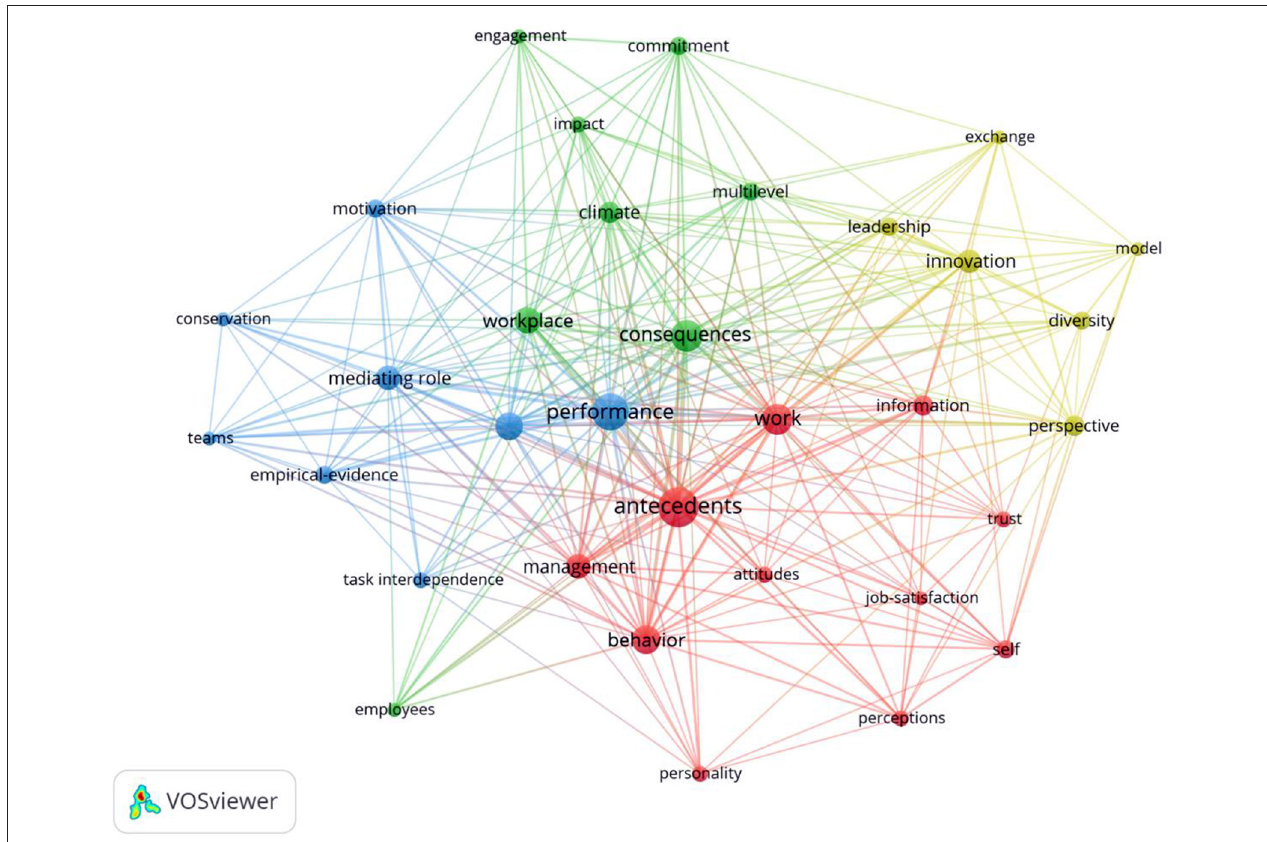
FIGURE 1 | An overview of the knowledge hiding literature. The database is “web of science core collection,” and the retrieval condition is “topic = knowledge hiding.” To ensure data accuracy, we carefully selected studies that fit the definition given by Connelly et al. (2012) and retained research articles, review articles, and online publications. This process yielded 182 articles (Retrieved on December 1,